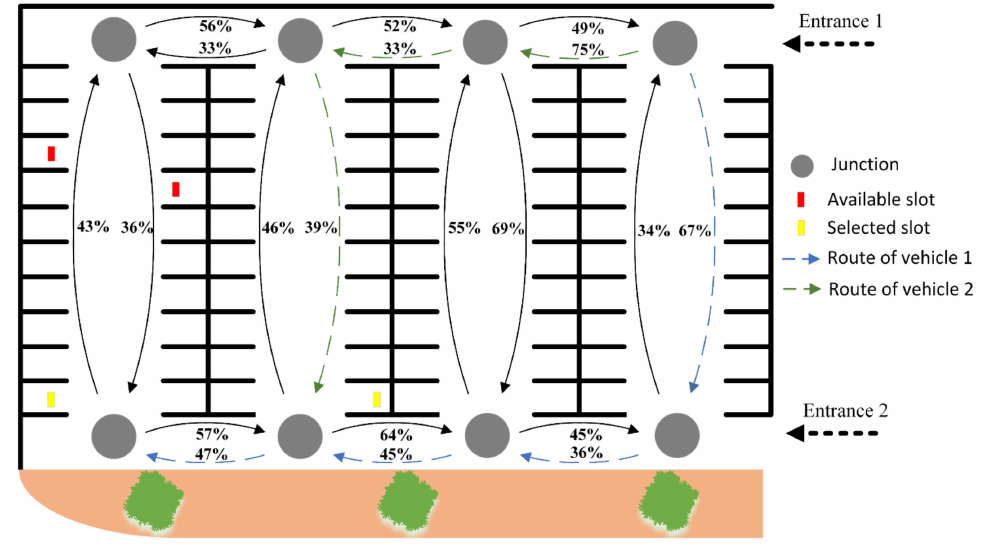
Figure 4. Parking-spot selection and vehicle